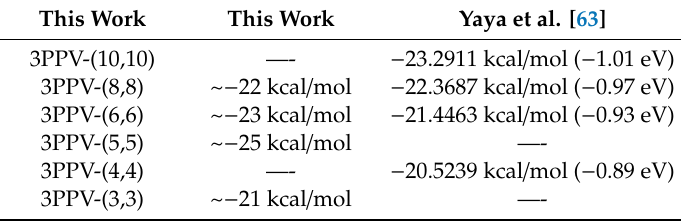
Figure 22. Binding energies of PPV oligomers w.r.t metallic SWCNT. Table 6. Binding energies of PPV oligomers w.r.t metallic SWCNT.